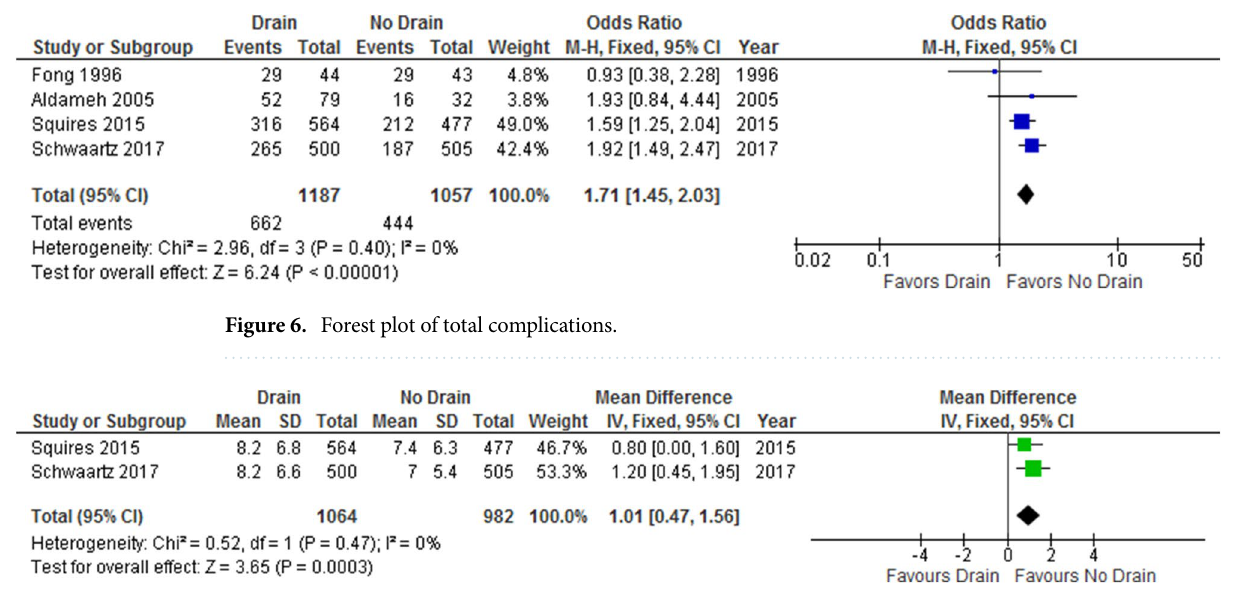
Figure 7. Forest plot of length of hospital